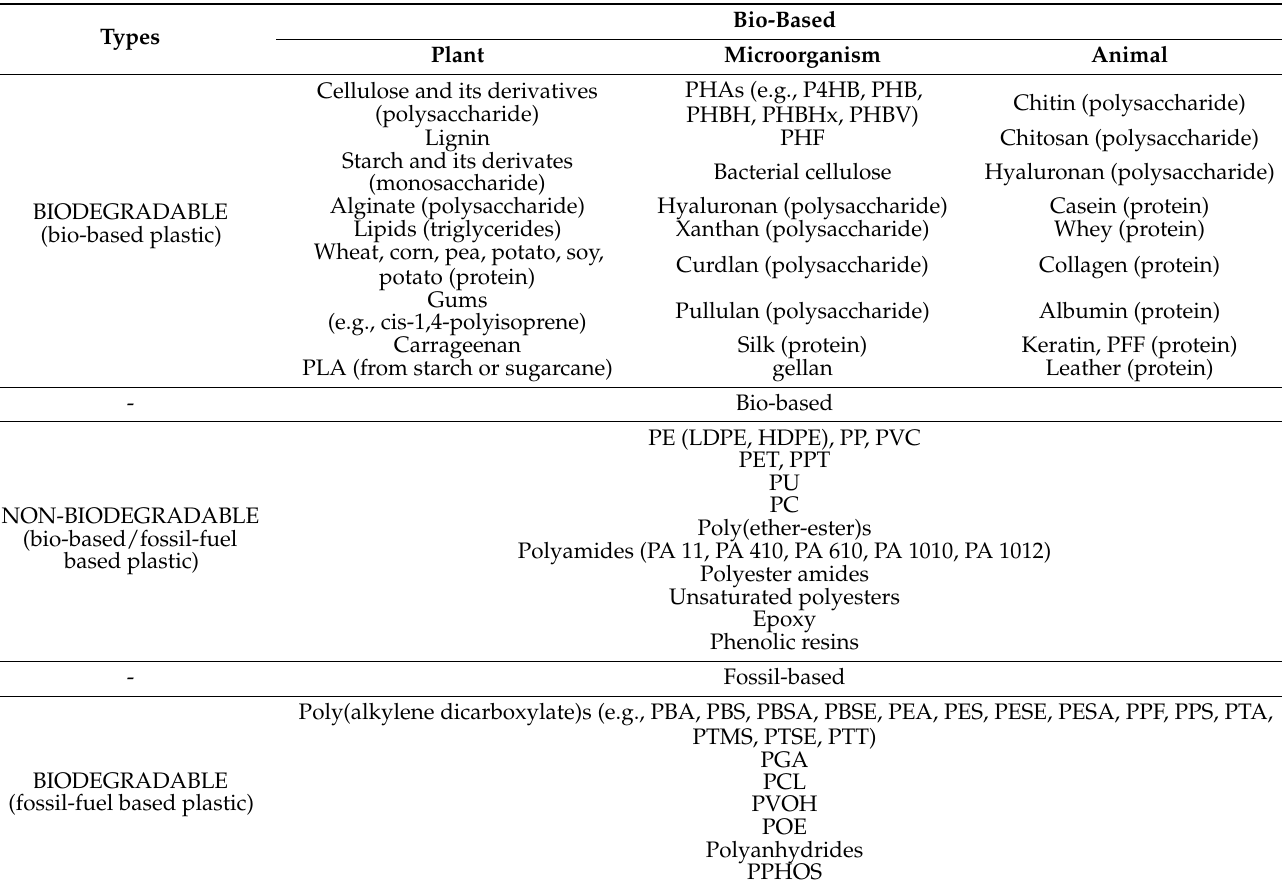
Table 2. Types of bio-based plastics and fossil-fuel-based